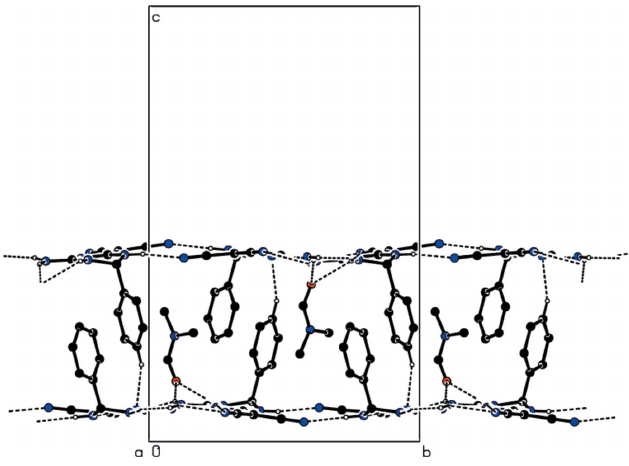
Figure 3 A partial view down the a axis of the N—H (cid:2)(cid:2)(cid:2) N, N—H (cid:2)(cid:2)(cid:2) O and C— H (cid:2)(cid:2)(cid:2) N hydrogen bonds (dashed lines) in the title compound. The minor disordered components have been omitted for clarity.